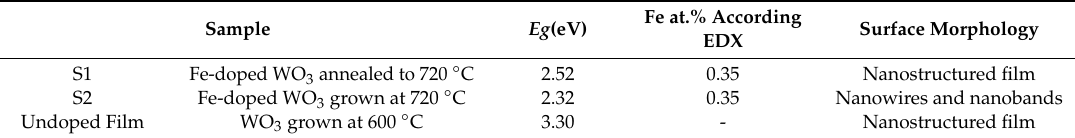
Table 6. A comparison of the E g for WO 3 and S1 and S2